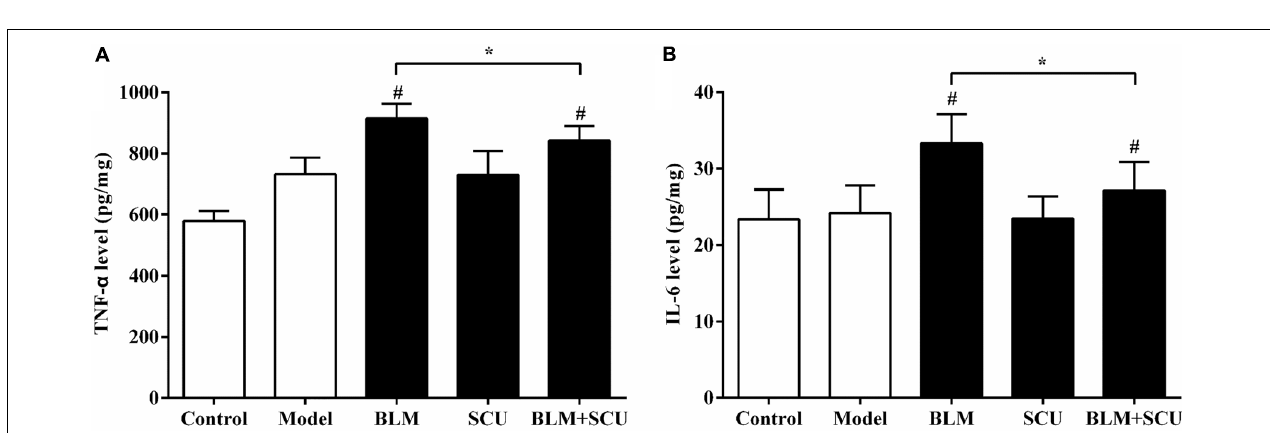
FIGURE 7 | Effects of SCU, BLM, and their combination on cytokine production in lung tissues of H22 tumor-bearing mice. (A) The levels of TNF- α in lung tissues. (B) The levels of IL-6 in lung tissues. The data are shown as the mean ± SD. ( n = 8). # p < 0.05 compared with model group; ∗ p < 0.05 compared with BLM